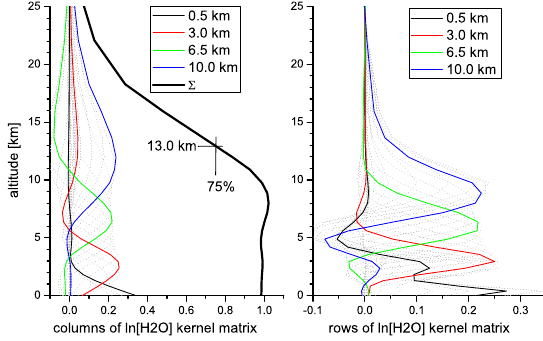
Fig. 2. Averaging kernel matrix for ln [ H 2 O ] . Left panel: column kernels; Right panel: row kernels. Grey dotted lines: for all atmo- spheric model grid levels; Black, red, green, and blue lines: for the 0 . 5, 3, 6 . 5, and 10km grid level, respectively; Thick black line in the left panel: Sensitivity (sum of the column kernels).